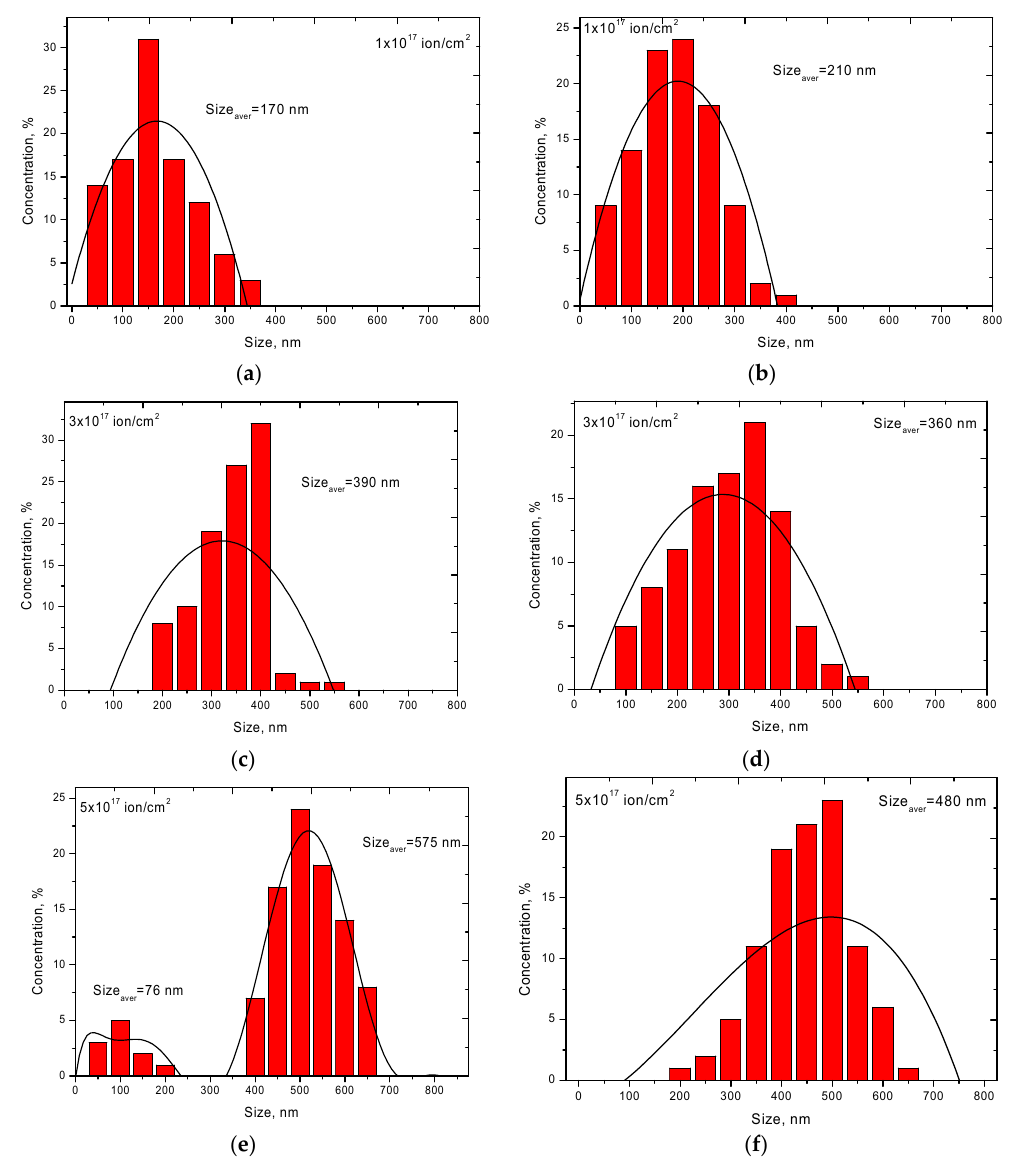
Figure 3. Dynamics of changes in the size of helium inclusions in the surface layer. ( a ) 10 17 ion/cm 2 , 300 K; ( b ) 3 x 10 17 ion/cm 2 , 300 K; ( c ) 5 x 10 17 ion/cm 2 , 300 K; ( d ) 10 17 ion/cm 2 , 1000 K; ( e ) 3 x 10 17 ion/cm 2 , 1000 K; ( f ) 5 x 10 17 ion/cm 2 , 1000 K.